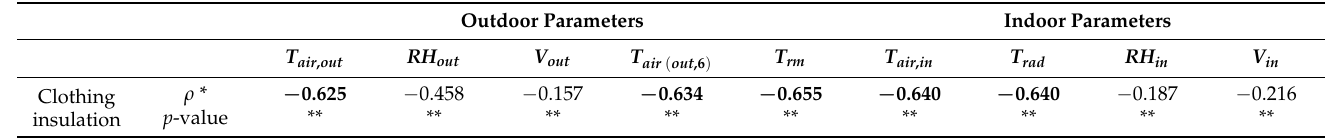
Table 5. Correlation between clothing insulation and environmental